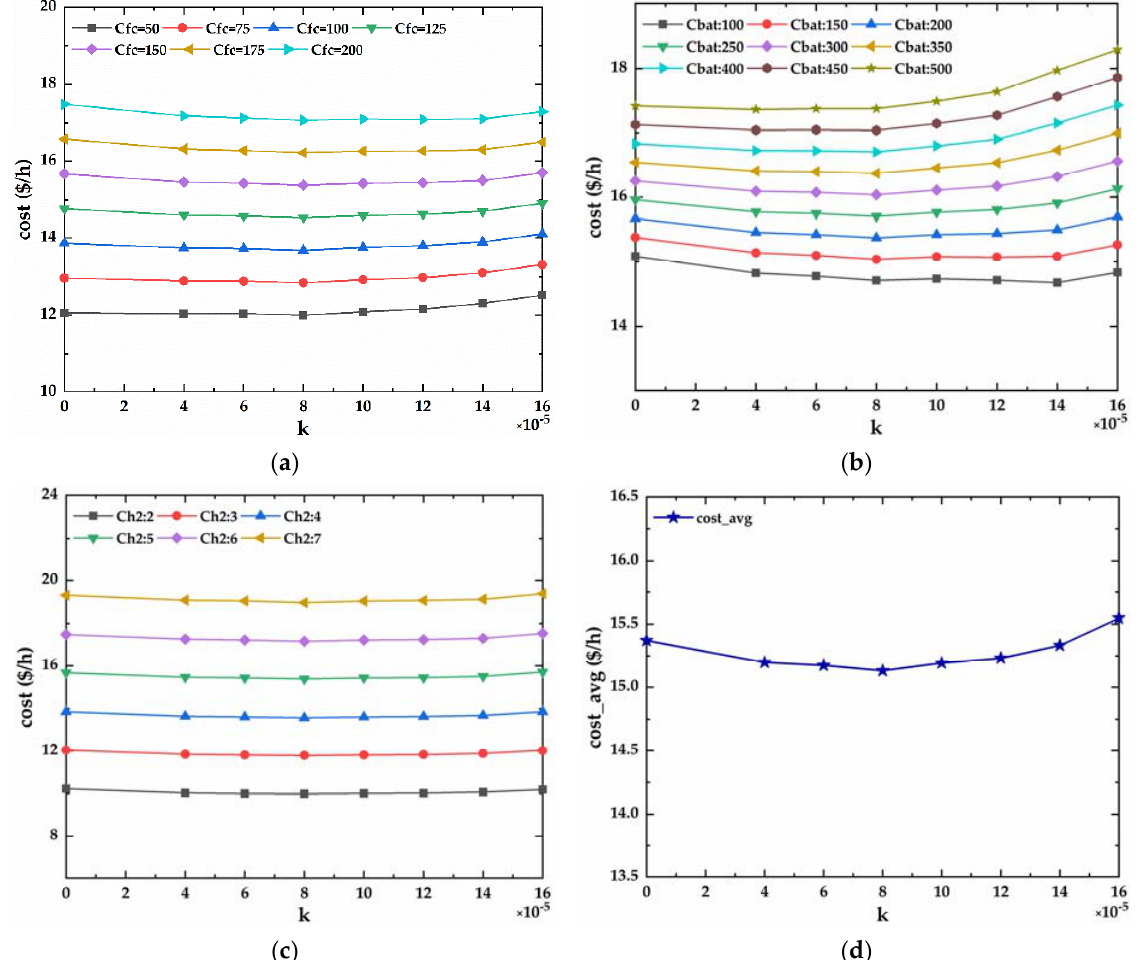
Figure 12. Comparison of the curve of cost function with k value under different unit price. ( a ) C fc = 50:25:200, C bat = 200, C H 2 = 5; ( b ) C fc = 150, C bat = 100:50:500, C H 2 = 5; ( c ) C fc = 150, C bat = 200, C H 2 = 2:1:7; ( d ) Average value. Comparing the P-PMP strategy when k is 8 × 10 − 5 with the PMP strategy only considering fuel economy, the simulation results under CWTVC condition are shown in Figure 13.